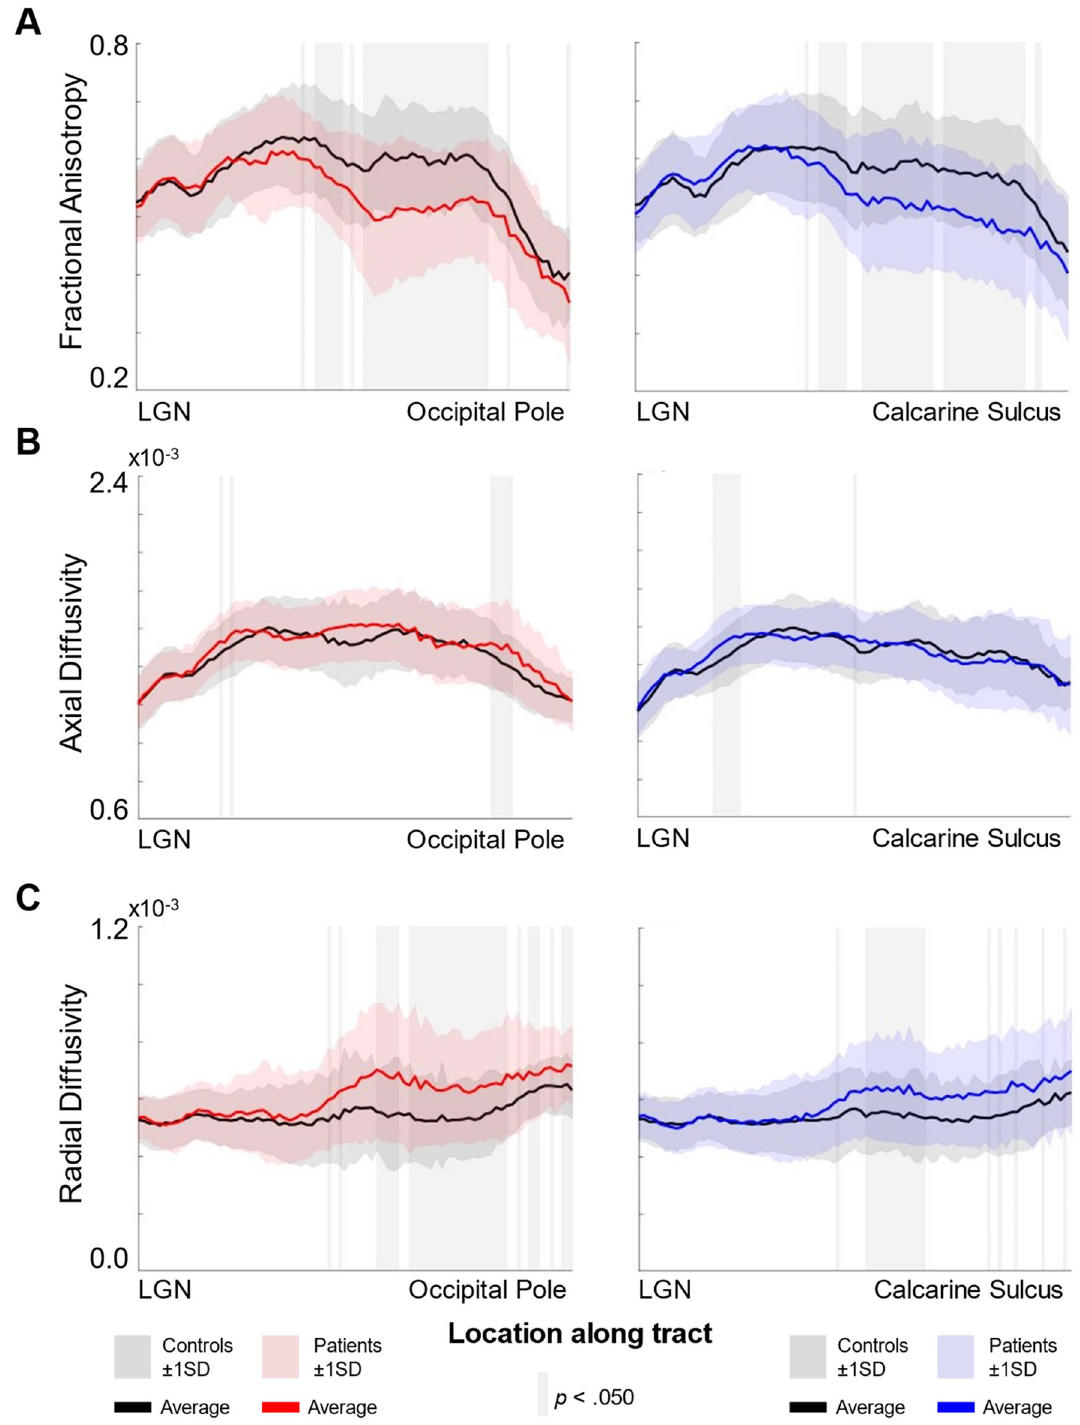
Figure 5. ( A ) Mean fractional anisotropy (FA) for controls (black line) and MD patients (red/blue lines). ( B ) Mean axial diffusivity (AD) measures for controls and MD patients. ( C ) Mean radial diffusivity (RD) measures for controls and MD patients. Standard deviation is shown in the shaded regions surrounding the group mean lines (dark grey for controls, red/blue for MD patients). Data are presented for our projections to: (from left to right) the occipital pole and calcarine sulcus. Locations along the tract profile that emerged significantly different between groups is shown in shaded grey columns ( p <